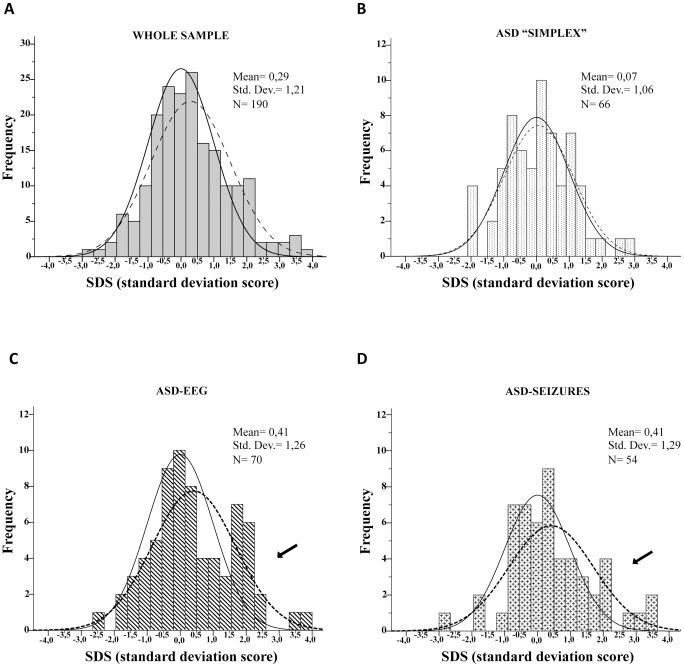
Distribution of Z-scores for height (Zh).
A. The histogram of Zh of whole sample shows a significant rightward shift (dashed curve) compared to the normative distribution (closed curve). B. The Zh distribution of ASD “simplex” group shows no difference with respect to normative distribution. C. The Zh distribution of ASD-EEG group shows a significant rightward shift (dashed curve) compared to the normative distribution (closed curve). D. The Zh distribution of ASD-seizures group shows a trend towards a rightward shift (dashed curve) compared to the normative distribution (closed curve). Arrows in C and D indicate a clearly higher rate of tall individuals over 1.5 SDS.